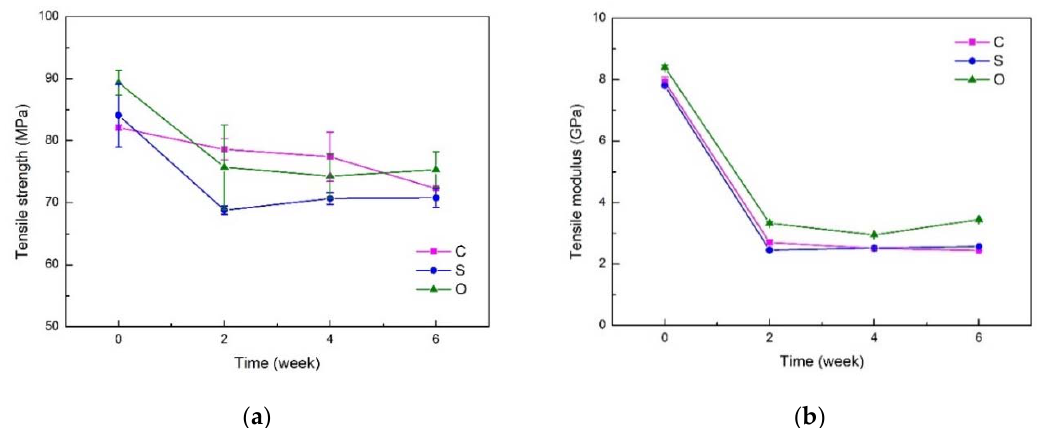
Figure 9. Effect of water absorption on the tensile properties ( a ) tensile strength ( b ) tensile modulus for FFRPs at 70 °C under 80% RH (C: untreated FFRPs; S: silane treated FFRPs; O: nano ‐ clay grafted FFRPs).